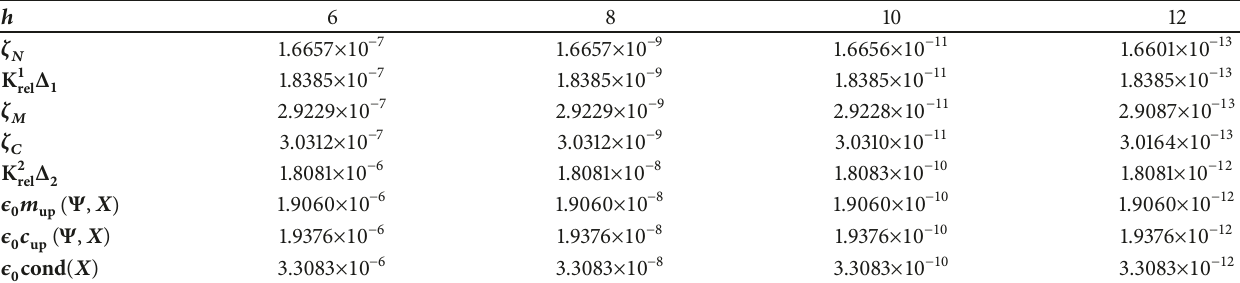
Table 5: Condition numbers and relative upper perturbation bounds for Example 4 evaluated at ℎ = {6,8, 10,12} . ℎ